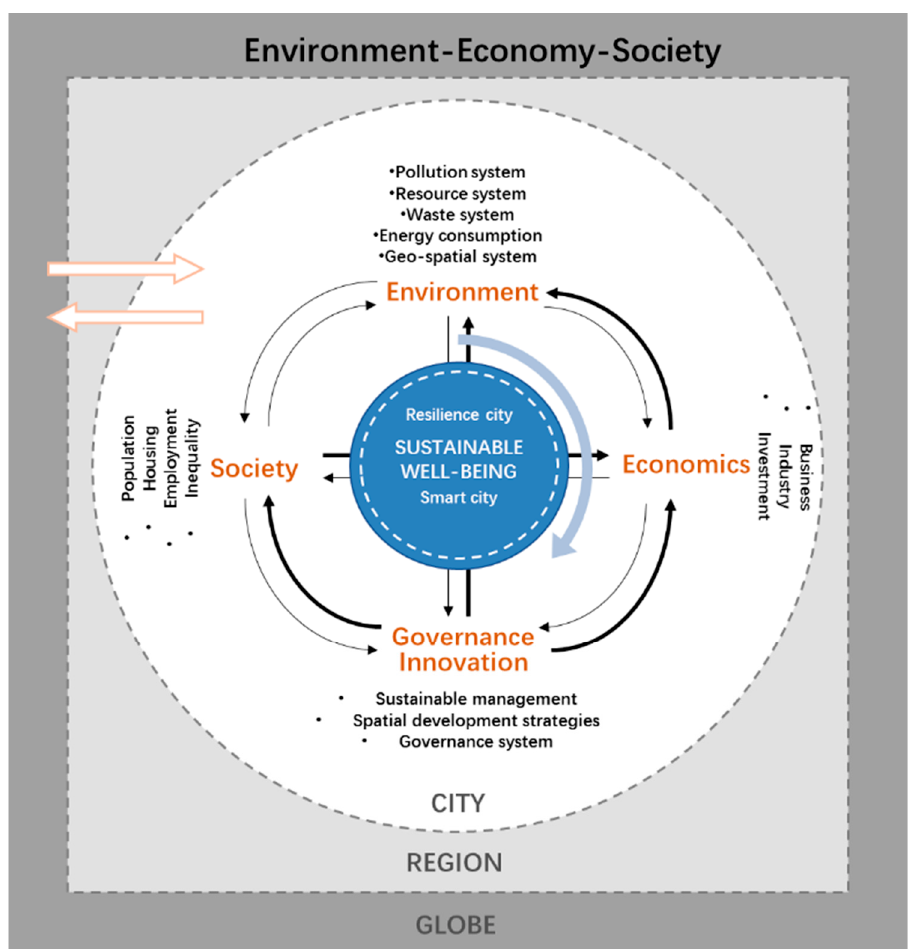
Figure 1. Complex urbanization and eco-environment system at cross-scales. Source: Drawn by authors.